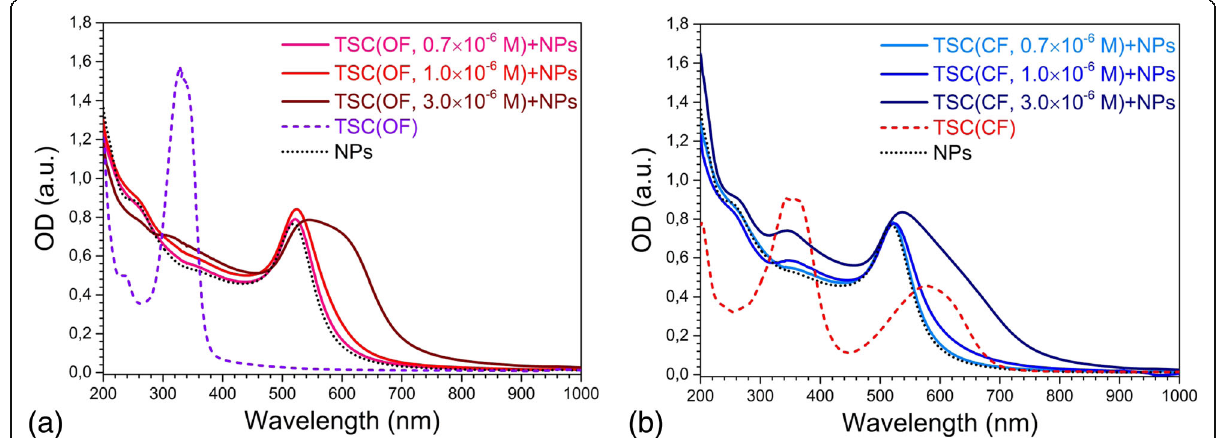
Fig. 7 Changes in absorption spectra of gold nanoparticles influenced by C5F-TSC in OF ( a ) and CF ( b ); the volume ratio of water to ethanol was equal to 5:1. The concentration of DAEs were C DAE = 0.7 × 10 − 6 , 1.0 × 10 − 6 , 3.0 × 10 − 6 M, but the control spectra C5F-TSC in OF and CF was